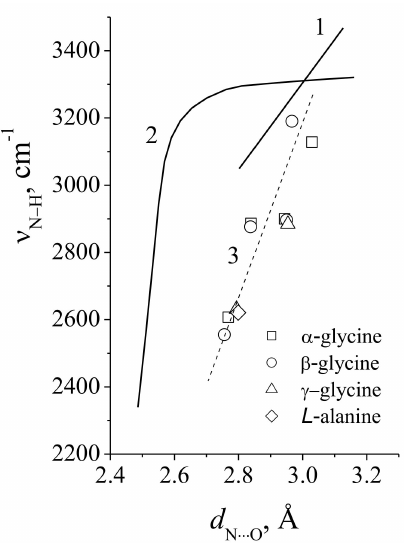
Figure 33. ν N–H stretching vibrations in the N–H ··· O hydrogen bond as function of N ··· O